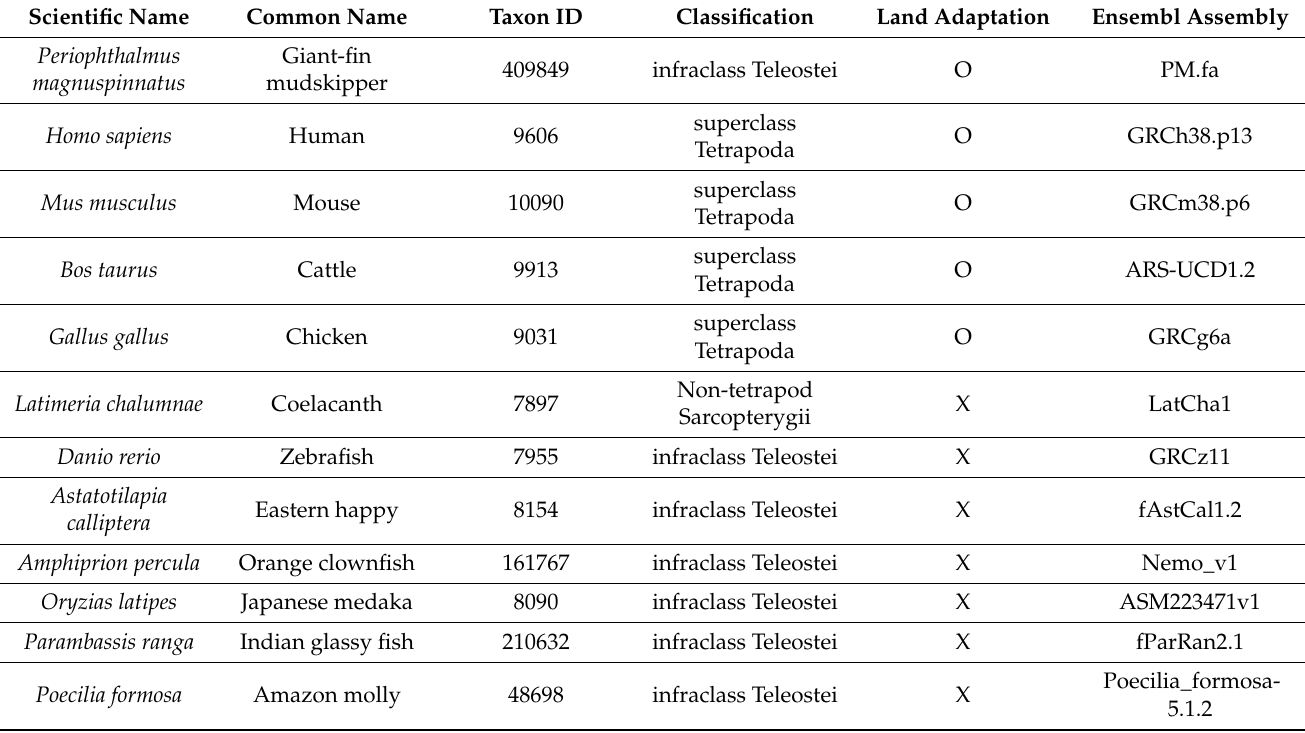
Table 1. Species information used in this